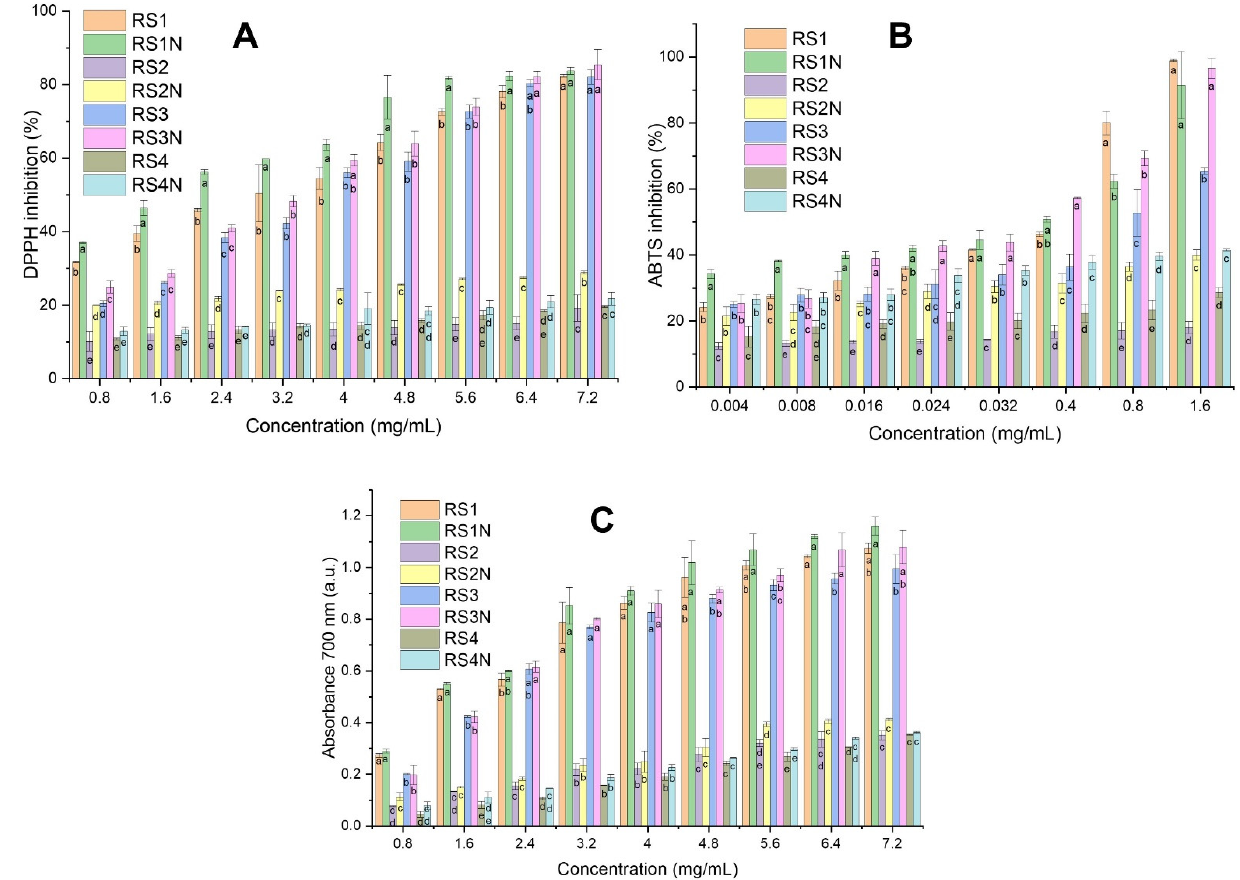
Figure 3. Antioxidant activity of analyzed extracts and silver nanoparticles: ( A )—DPPH assay, ( B )—ABTS assay, ( C )—ferric reducing power. For each tested concentration, values without a common letter differ ( p < 0.05) as analyzed by one-way ANOVA and the Tukey test.